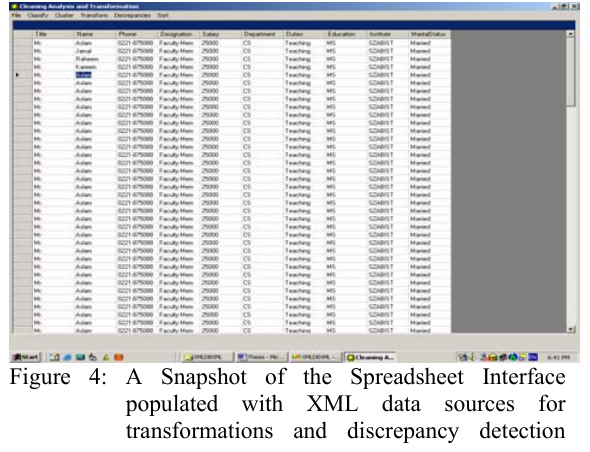
Figure 4: A Snapshot of the Spreadsheet Interface populated with XML data sources for transformations and discrepancy detection